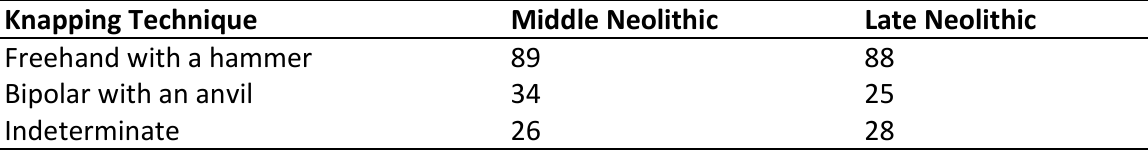
Table 5. Knapping techniques observed within the assemblage, divided by period.